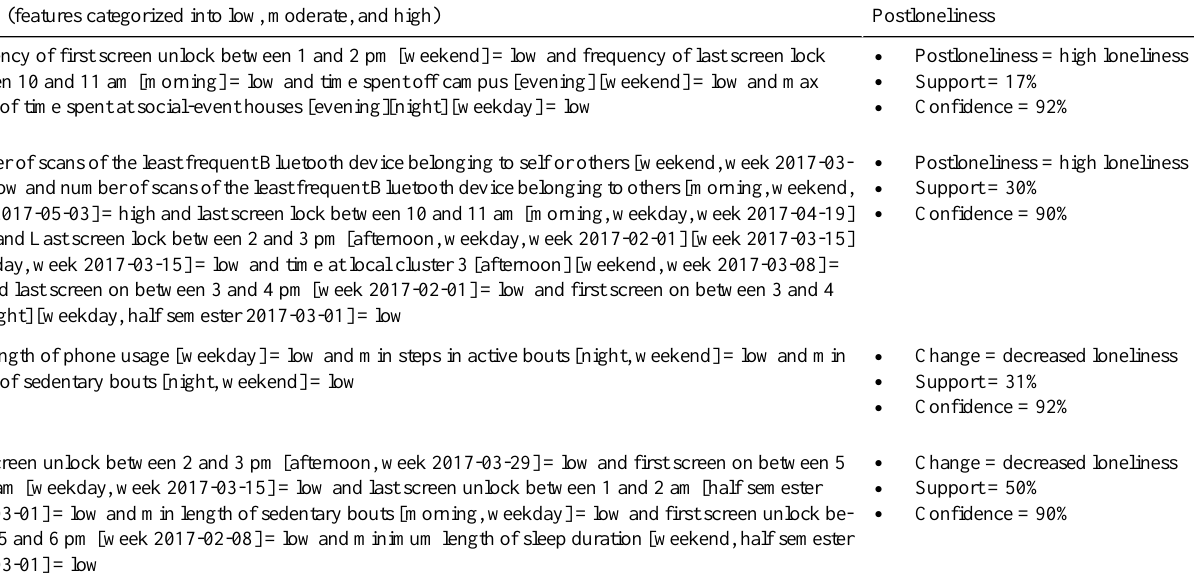
Table 6. Extracted patterns showing how combinations of behavioral features selected by the machine learning algorithm are associated with high loneliness and decreased